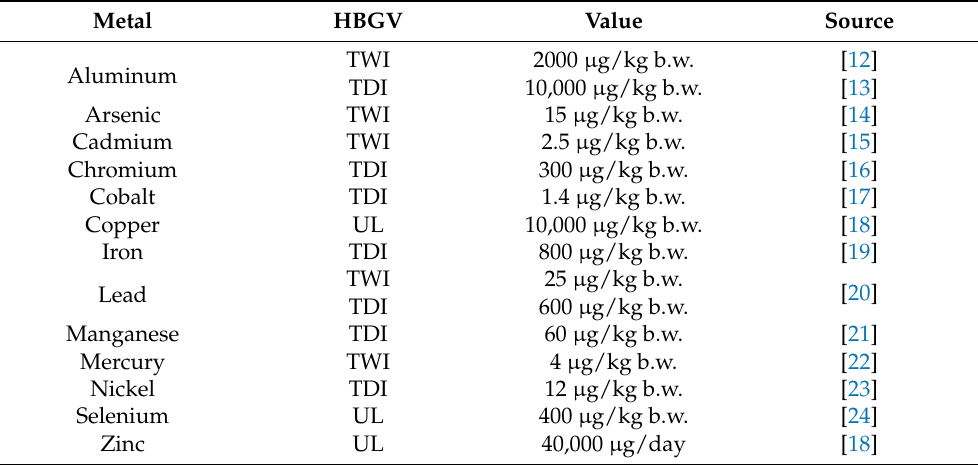
Table 1. Average tolerable intake of metals for a